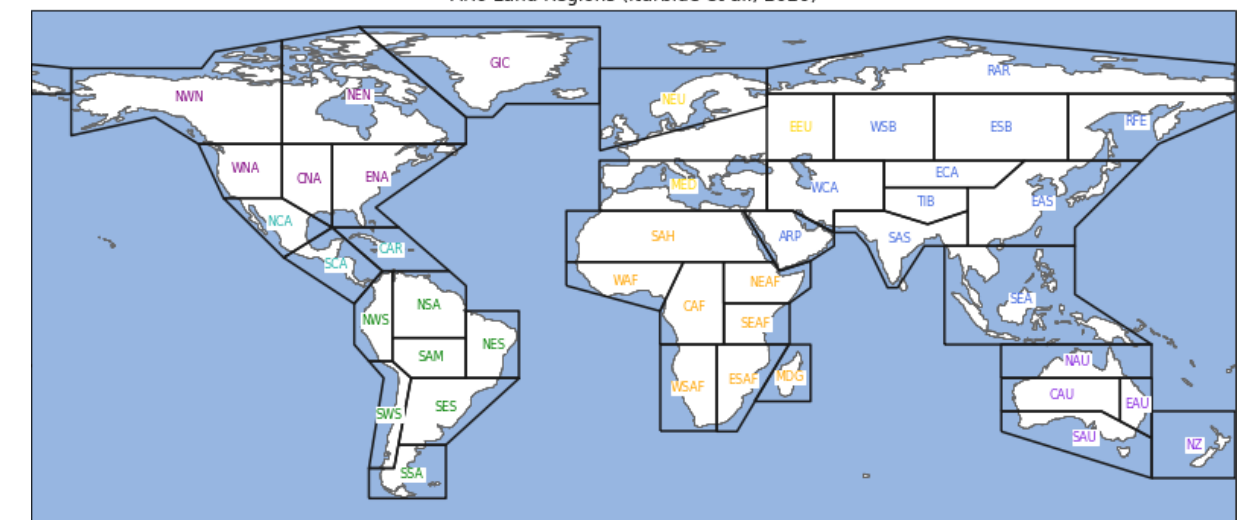
Figure 1. AR6 reference regions for land (source: Iturbide et al., 2020). Regional abbreviations are colored by continent to facilitate com- parison with other